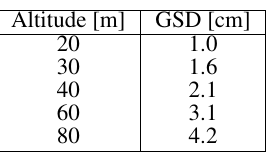
Table 1. Ground Sampling Distance (GSD) as function of the flight altitude with respect to the river bank